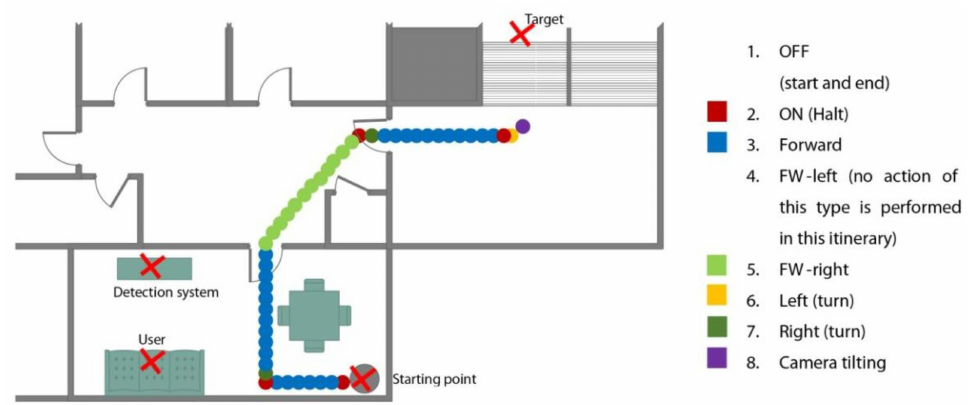
Figure 17. Driven itinerary throughout the house, with the state detected at each point.